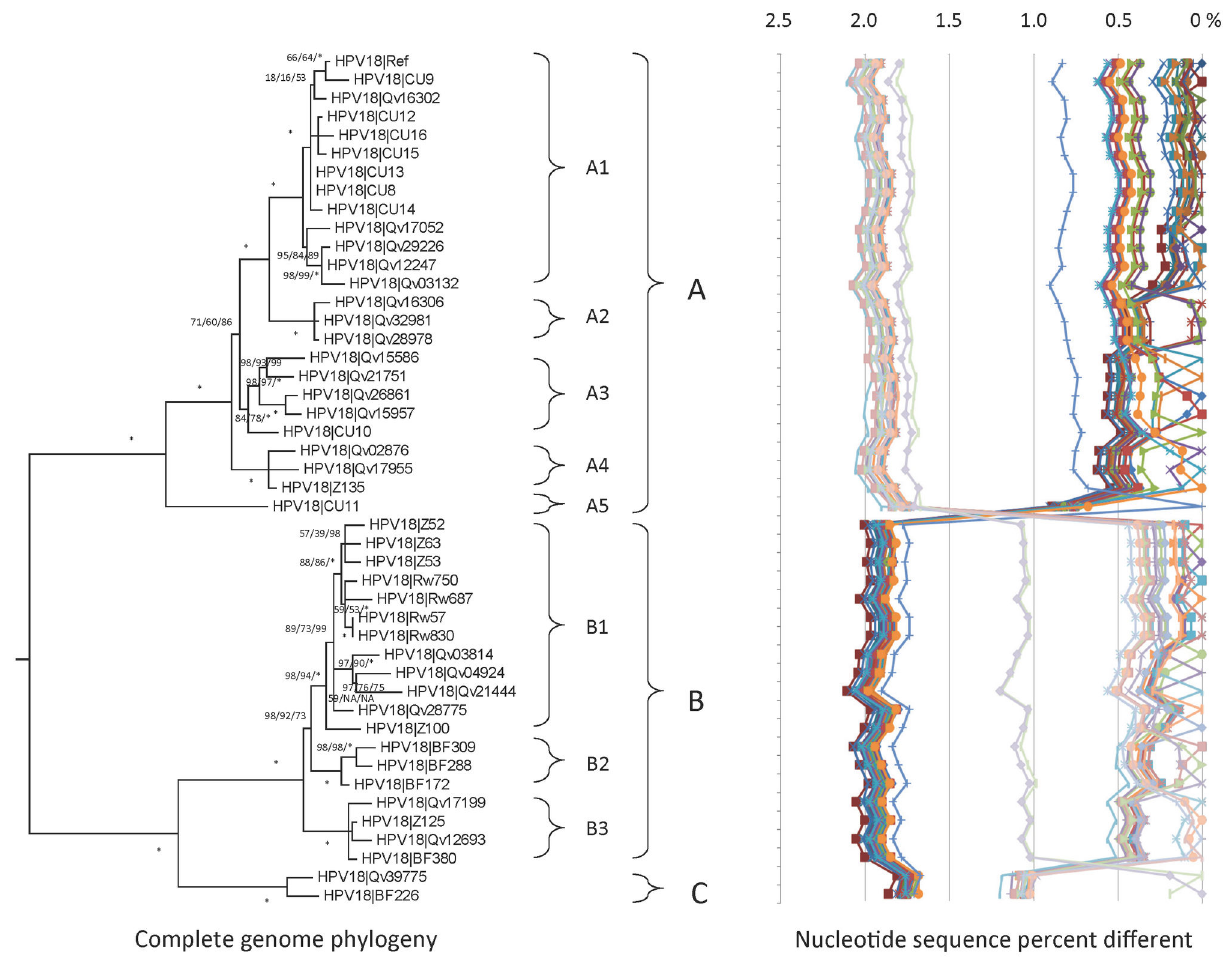
Figure 2. HPV18 tree topology and pairwise comparisons of individual complete genomes. Phylogenetic trees were inferred from global alignment of complete genome nucleotide sequences (the other alpha-7 HPV reference prototypes were set as the outgroup). Numbers on or near branches indicate support indices in the following order: maximum likelihood (ML) bootstrap percentages using RAxML MPI v 7.2.8.27 [42] and PhyML MPI v 1.4.3 [43], and Bayesian credibility value percentage using MrBayes v 3.1.2 [44]. An asterisk (*) indicates 100% agreement between methods. “NA” indicates disagreement between a method and the reference RAxML tree at a given node. Thus, one tree is shown, but three different methods of tree construction were used to estimate the support of the provided tree, as explained above. Distinct variant lineages (i.e., termed A, B, and C) are classified according to the topology and nucleotide sequence differences from > 1% to < 10%; distinct sublineages (e.g., termed A1 and A2) were also inferred from the tree topology and nucleotide sequence differences in the > 0.5% to < 1% range. The percent nucleotide differences for each isolate compared to all other isolates (i.e., 1 x 1 comparisons) are shown in the panel to the right of the phylogeny. Values for each comparison of a given isolate are connected by lines and the comparison to self is indicated by the 0% difference point. Symbols and colored lines are used to distinguish each isolate. doi: 10.1371/journal.pone.0072565.g002 GGS), and a 52 bp repeat was detected within the URR region of isolate Qv29509 (an A1 variant). All HPV39 isolates from Costa Rica mapped to either the A1 (67%, 70/105) or A2 (33%, 35/105) lineages; whereas, the few samples from Taiwan sorted to A2 (2/4) or B (2/4), the Rwandan samples sorted to lineages A (7/8) or B (1/8) but all 5 samples from Burkina Faso mapped to lineage B.